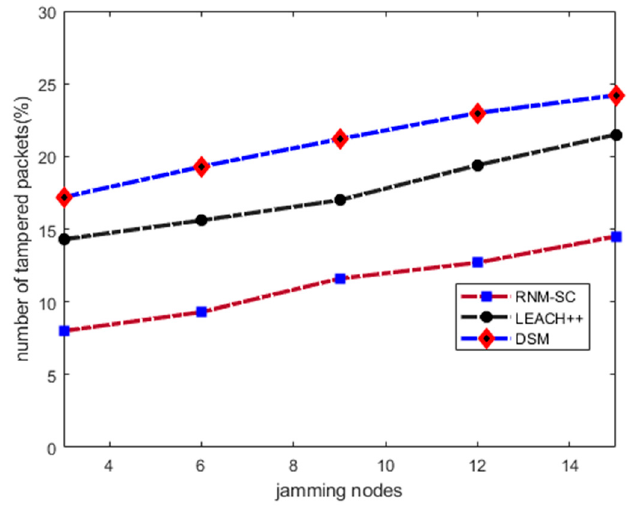
Figure 8. Tampered packets and jamming nodes .